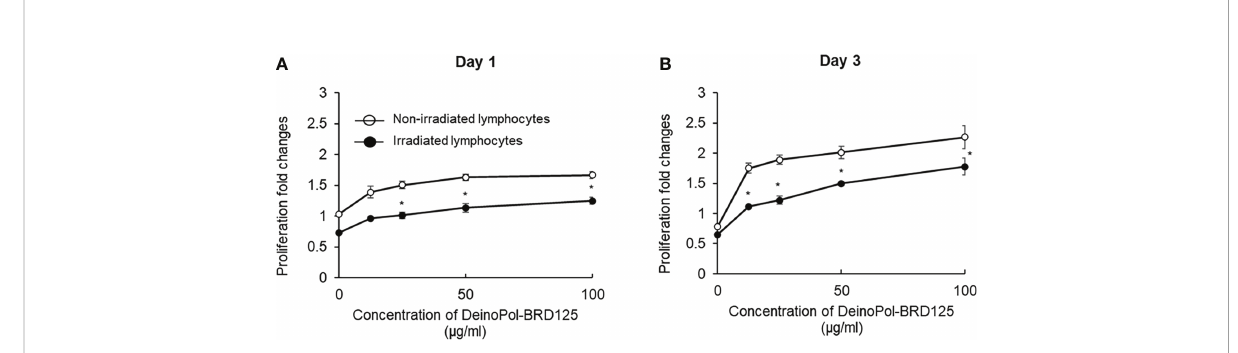
FIGURE 3 Enhancement of the proliferation of immune cells by DeinoPol-BRD125. (A, B) Splenic lymphocytes (3×10 5 /well) were pretreated with indicated concentration of DeinoPol-BRD125 for 2 h followed by irradiation (1 Gy). Cell proliferation was measured with bromodeoxyuridine (BrdU) proliferation assay kit at day 1 (A) and day 3 (B) after irradiation. *p<0.05 compared to cells without